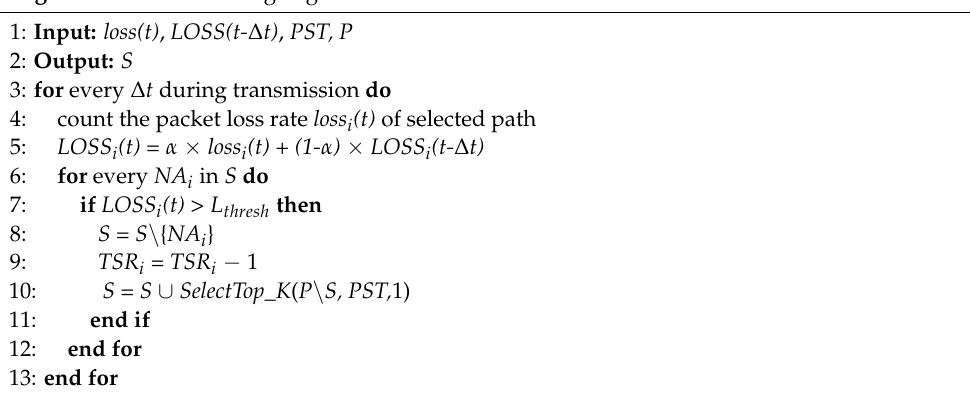
Algorithm 2 Path Switcing